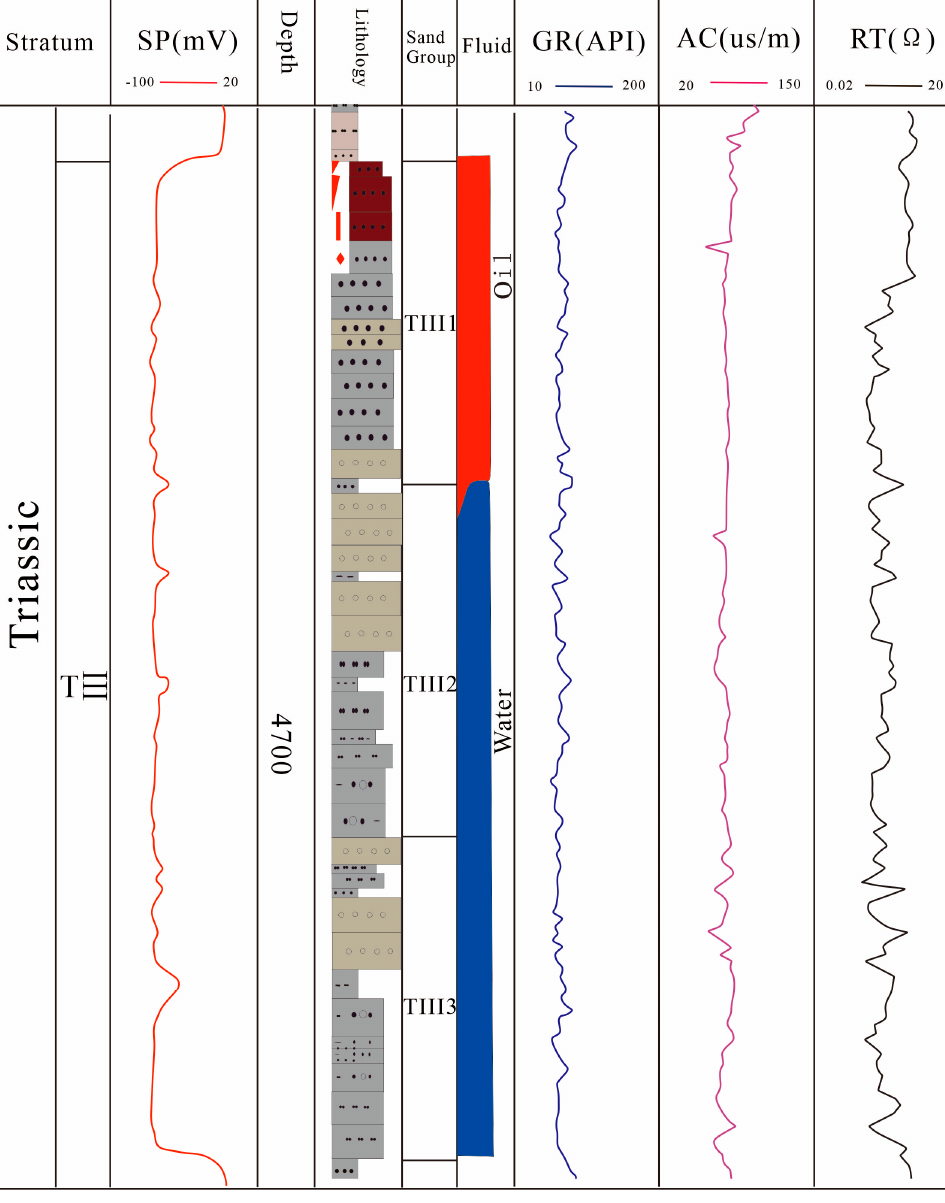
Figure 2. Comprehensive stratigraphic column of the Sangtamu oilfield.